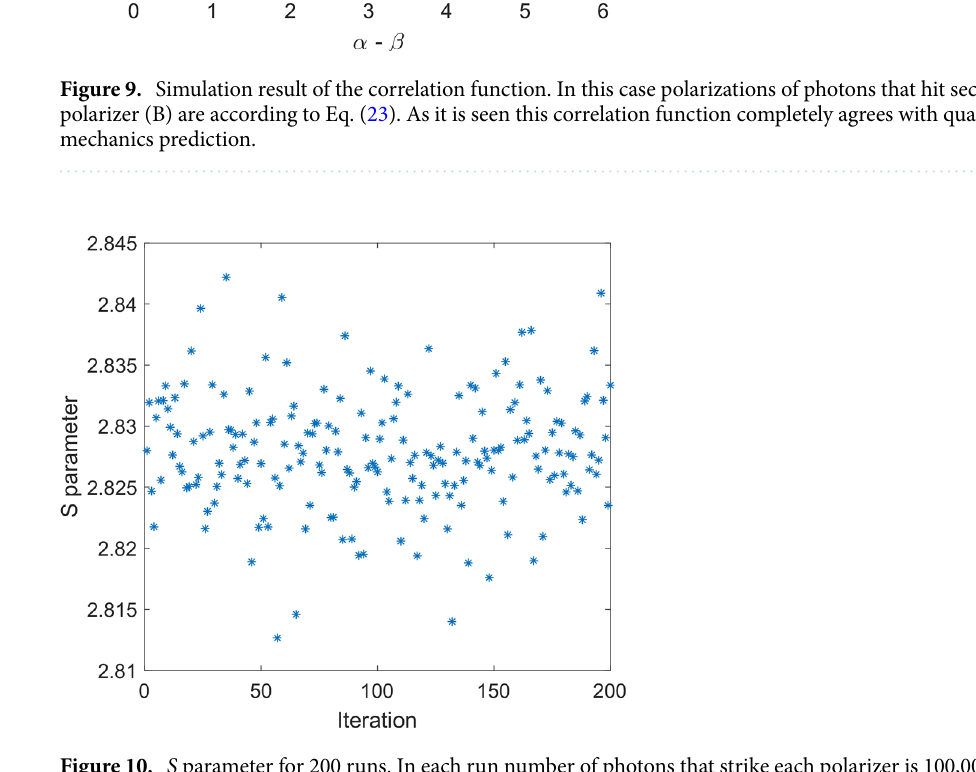
Figure 10. S parameter for 200 runs. In each run number of photons that strike each polarizer is 100,000. Polarization of photons that hit B polarizer obey (23). Mean value of S parameter in this example is equal to 2.828 while angles of polarizers are α 1 = 3 π/ 8, β 1 = π/ 4, α 2 = π/ 8, β 2 = 0